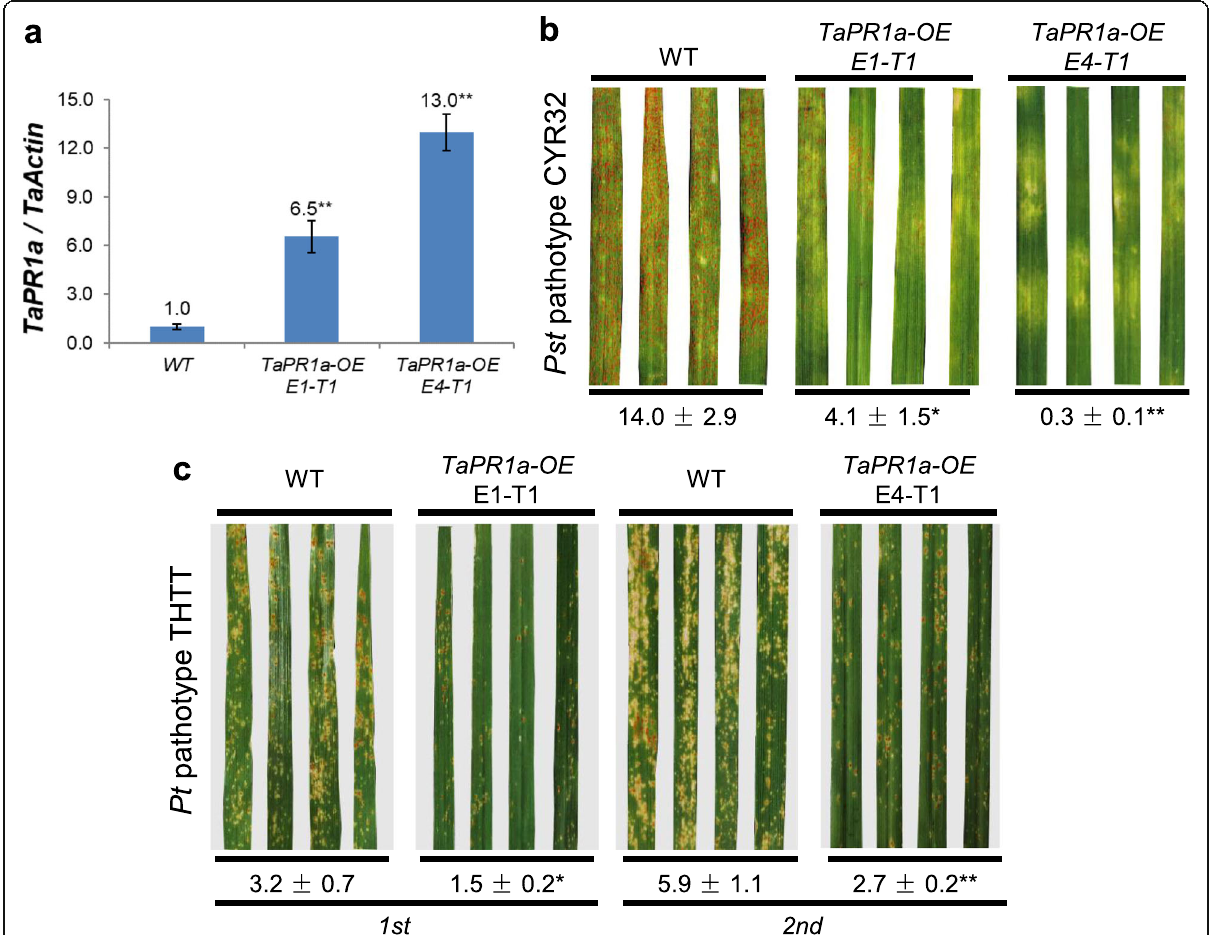
Fig. 4 Transgenic wheat line TaPR1a-OE showed enhanced resistance to both Pst and Pt . a The transcript levels of TaPR1a in TaPR1a-OE were determined by RT-qPCR. b The phenotypes of TaPR1a-OE and wild-type plants in response to the highly virulent Pst pathotype CYR32. c The susceptibility phenotypes of TaPR1a-OE and wild-type plants to the Pt pathotype THTT. The numbers below the images of the leaves represent the average percentages of the rust sporulation area in each inoculated leaf. The asterisks (* P < 0.05, ** P < 0.01) indicate the significance of the differences between the transgenic line and wild-type plants as assayed by Dunnett ’ s